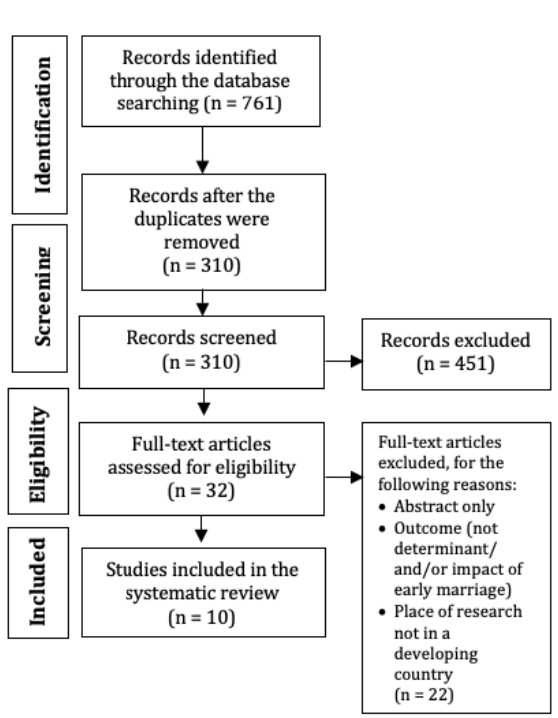
Figure 1. Flow diagram of the literature search used to identify the determinants and impacts of early marriage in developing